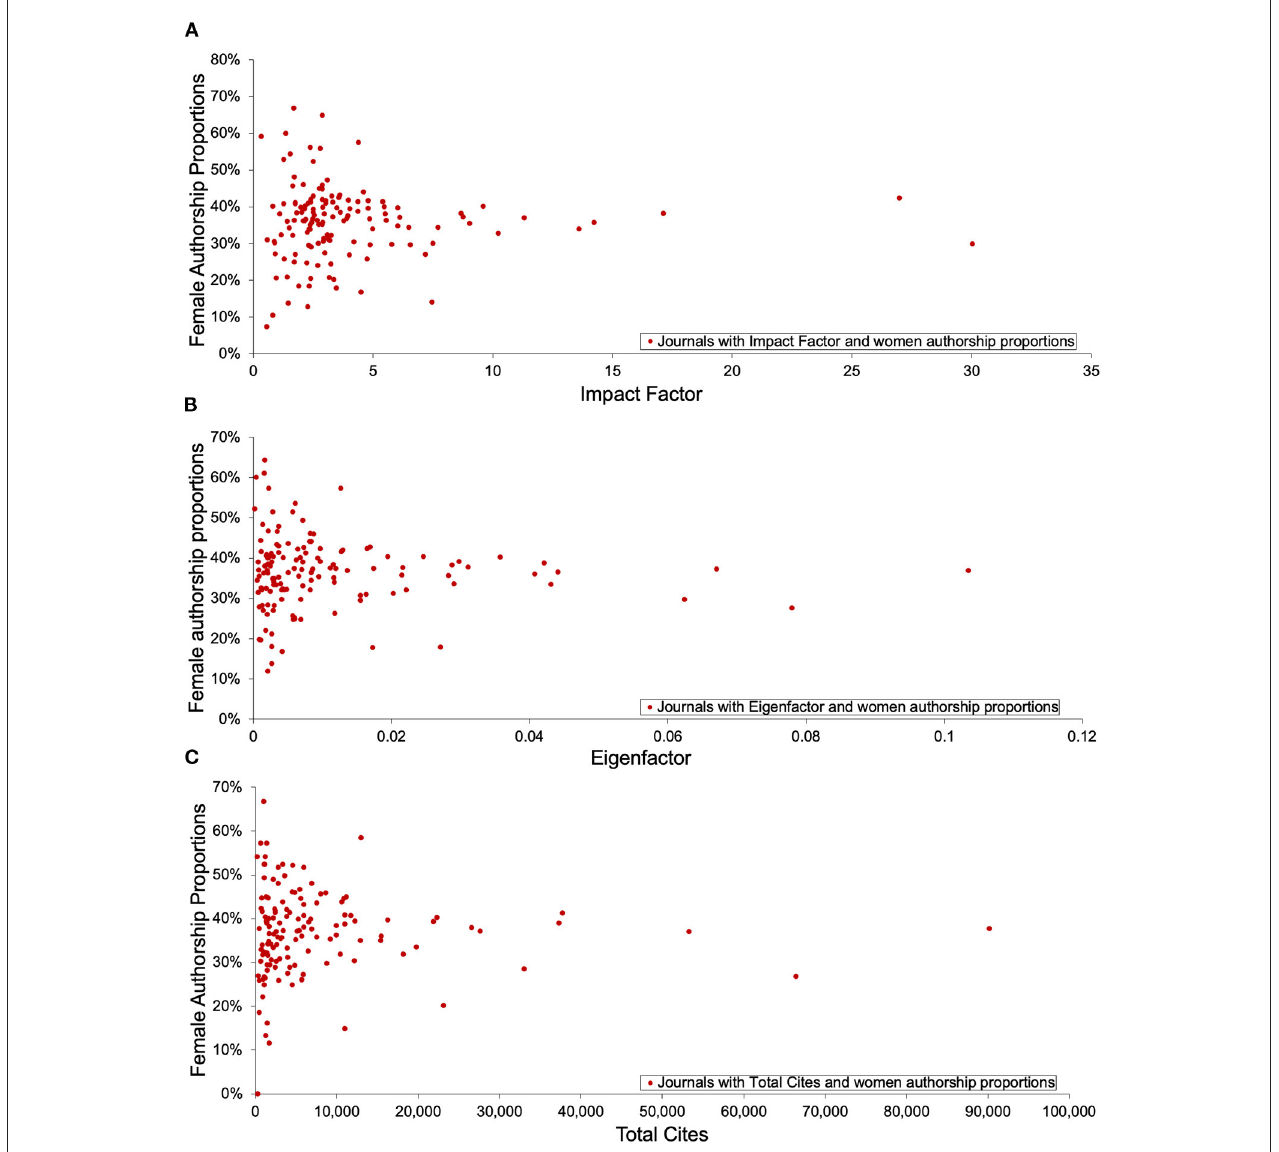
FIGURE 5 | Correlations between author proportions and journal indicator. (A) Correlation between Journal Impact Factor (from JCR 2019) and associated women author proportions (2017–2018 data) per journal, (B) Correlation between Eigenfactor Score (from JCR 2019) and women author proportions (2015–2019 data) in each journal, (C) Correlation between Total Cites (from JCR 2019) and women author proportions (2019 data) in each journal.